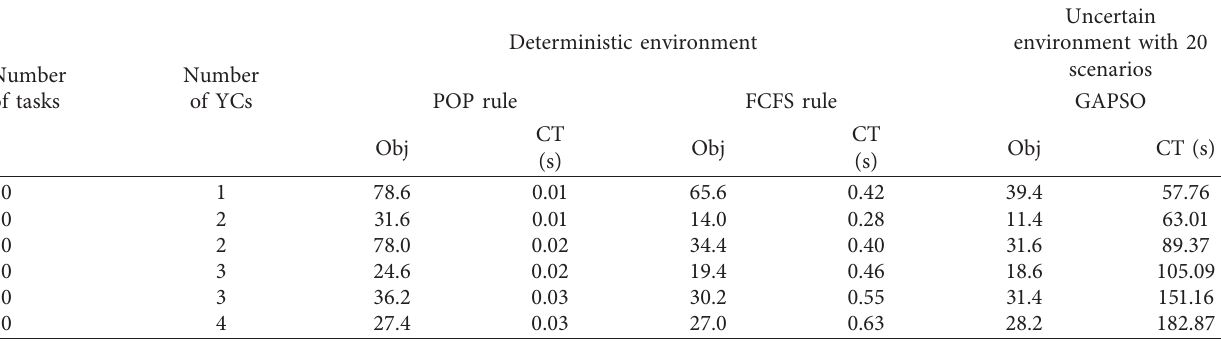
Table 3: The experiment result comparison of